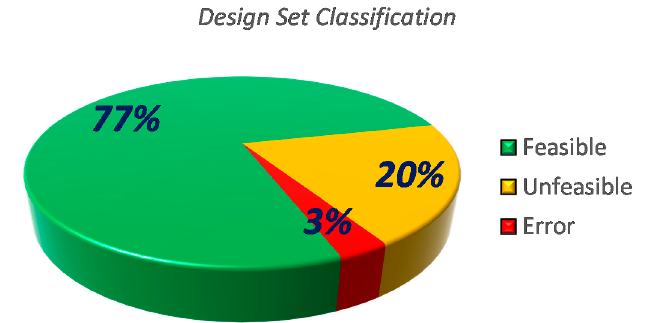
Figure 27. Feasible, unfeasible, and failed individuals.